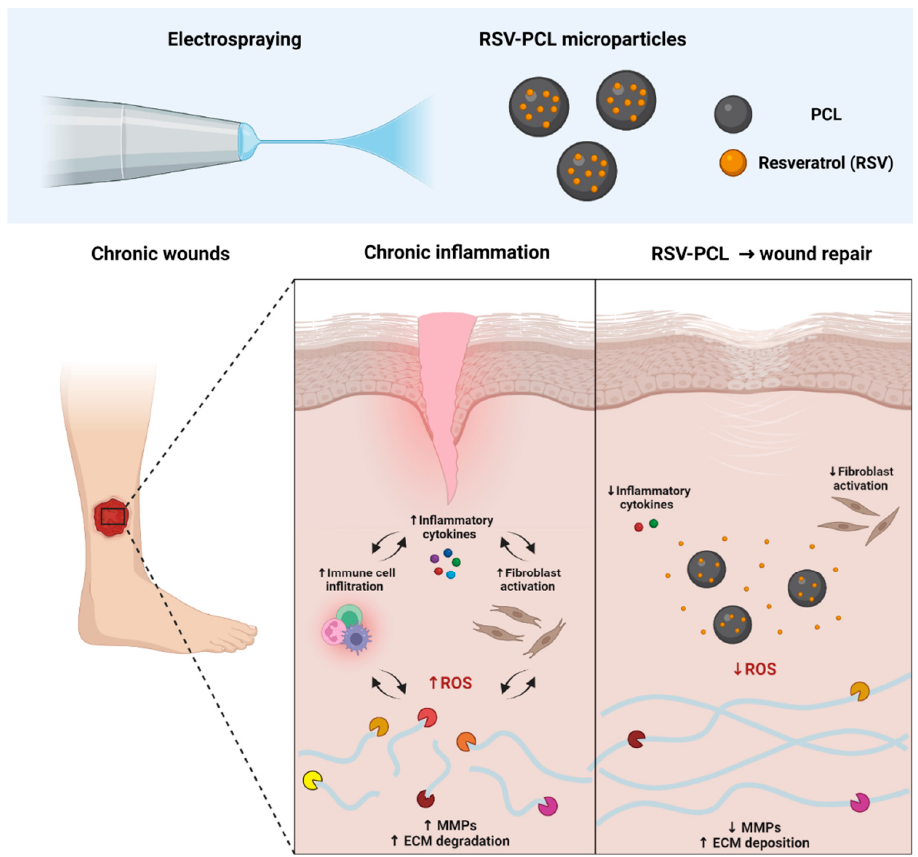
Figure 9. Chronic wounds are characterized by a chronic state of inflammation sustained by abundant immune cell infiltration, which increases the presence of inflammatory cytokines and creates a highly pro-oxidant microenvironment. This leads to the activation of tissue-resident fibroblasts, which contribute to the persistence of local inflammation by further secreting pro-inflammatory factors. Furthermore, excessive production of matrix metalloproteinases (MMPs) generates a highly proteolytic microenvironment, degrading structural components of the extracellular matrix (ECM). Controlled and sustained delivery of RSV through electrosprayed polymeric carriers may represent a valuable therapeutic method for the treatment of chronic wounds, specifically targeting the vicious cycle of inflammation, proteolysis, and inadequate repair. Created with BioRender.com (accessed